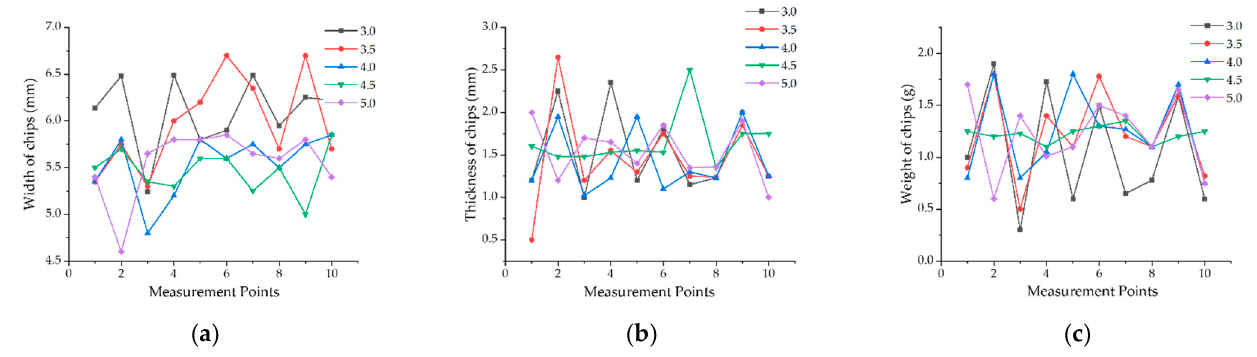
Figure 10. Measuring results of the cutting depth test in groups [18]. ( a ) Chip width measurement results, ( b ) chip thickness measurement results, ( c ) chip weight measurement results.